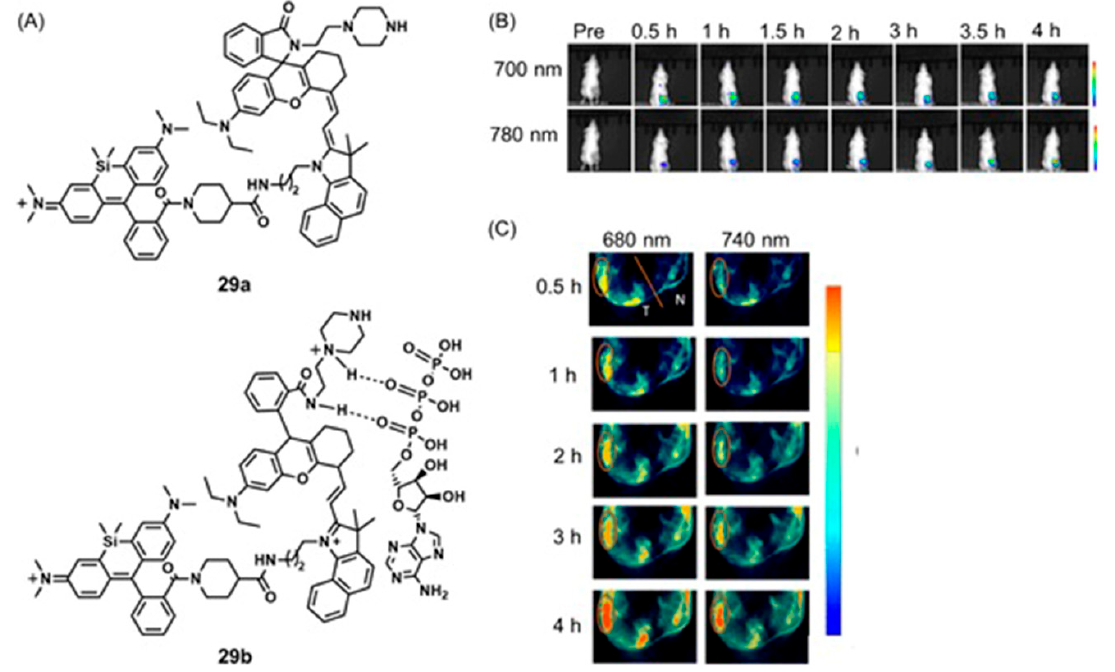
Figure 53. ( A ) Chemical structures of 29a and 29b . ( B ) Time-dependent dual-channel fluorescence images of tumor-bearing mice after intravenous injection of 29a . Excitation wavelength = 660 nm; emission wavelengths = 700 ± 10 and 780 ± 10 nm. ( C ) Time-dependent dual-channel photoacoustic images of tumor-bearing mice after intravenous injection of 29a . Excitation wavelengths = 680 and 740 nm. Adapted with permission from Liu, X.; Gong, X.; Yuan, J.; Fan, X.; Zhang, X.; Ren, T.; Yang, S.; Yang, R.; Yuan, L.; Zhang, X.-B. Dual-stimulus responsive near-infrared reversible ratiometric fluorescent and photoacoustic probe for in vivo tumor imaging. Anal. Chem. , 2021 , 93 , 5420–5429. Copyright 2021 American Chemical Society [369].